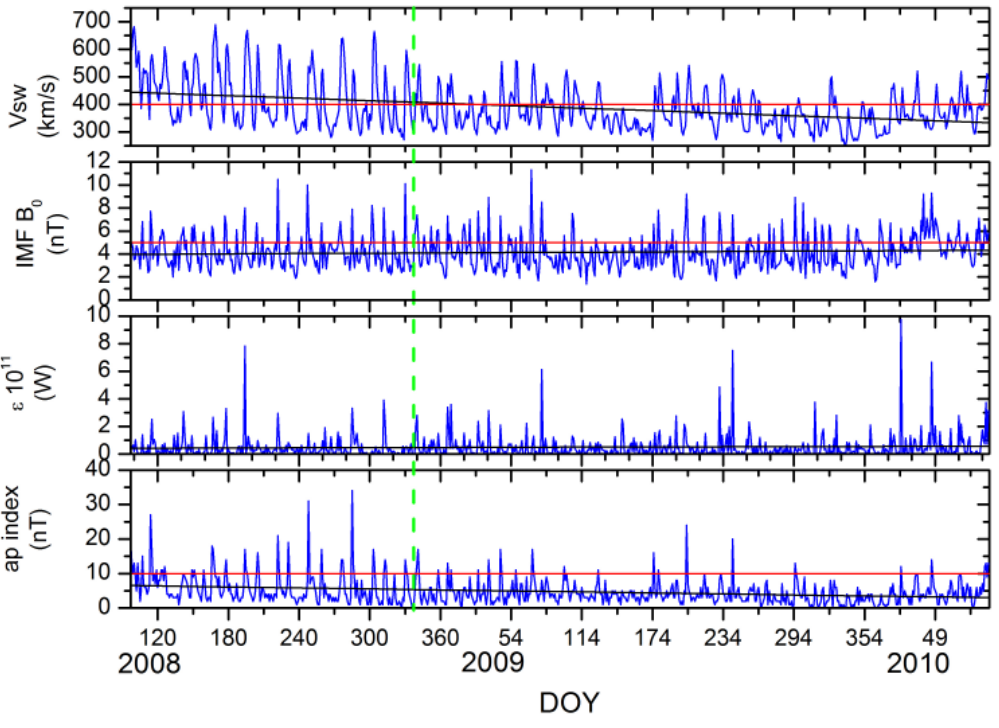
Fig. 2. An expanded view of MGA23. The same horizontal red lines shown in Fig. 1 are duplicated here for reference. The black lines give linear regression fits to the